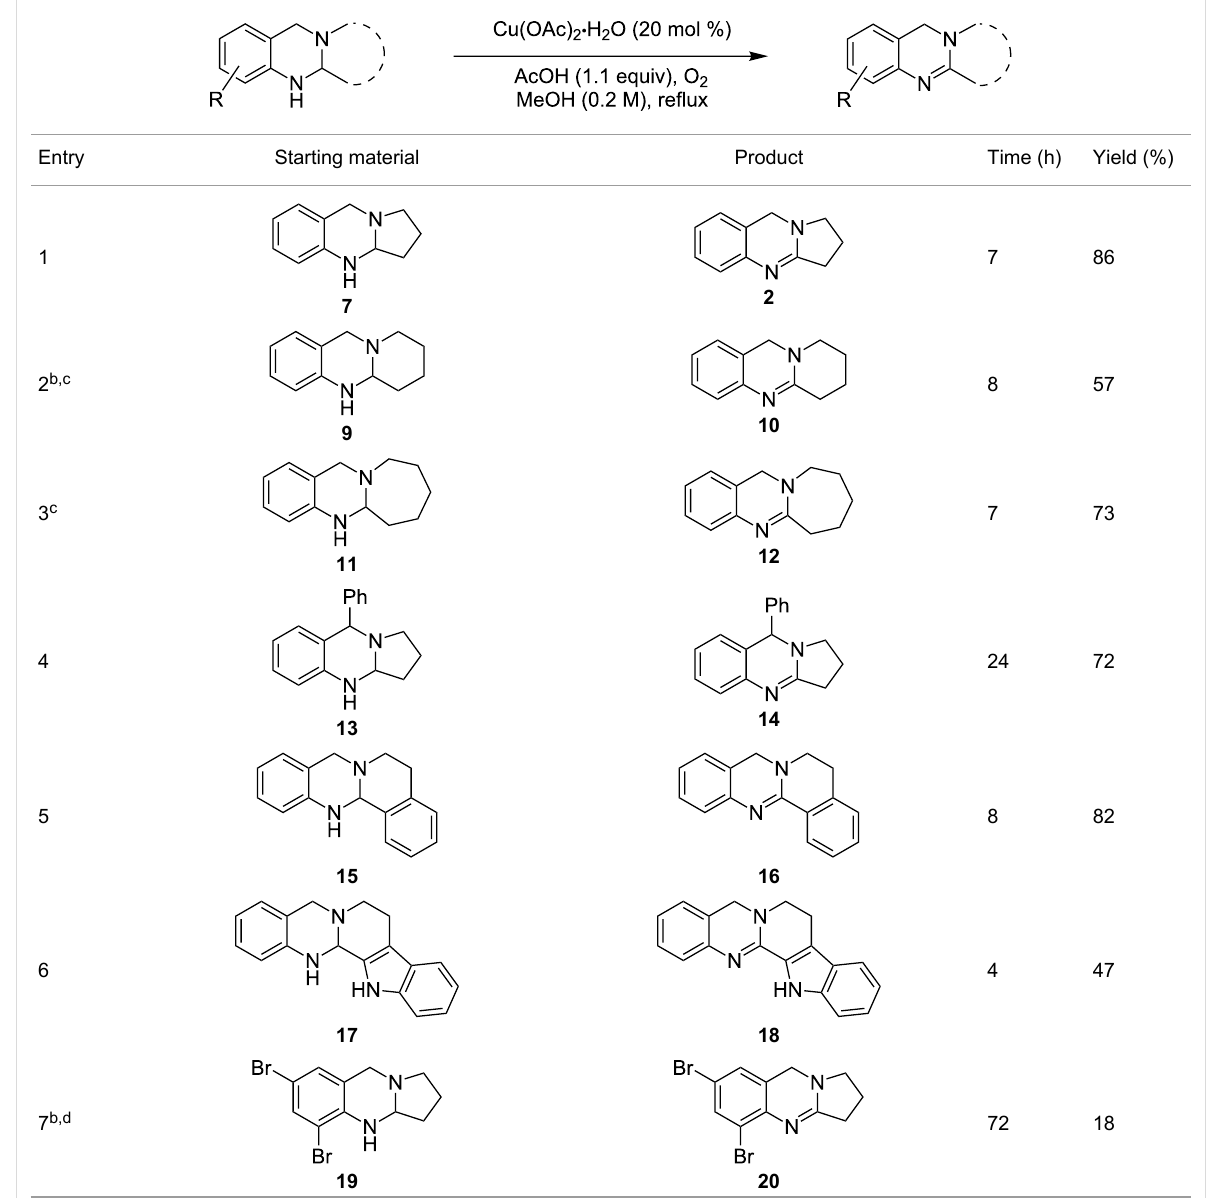
Table 2: Scope of the copper-catalyzed conversion of aminals to dihydroquinazolines. a